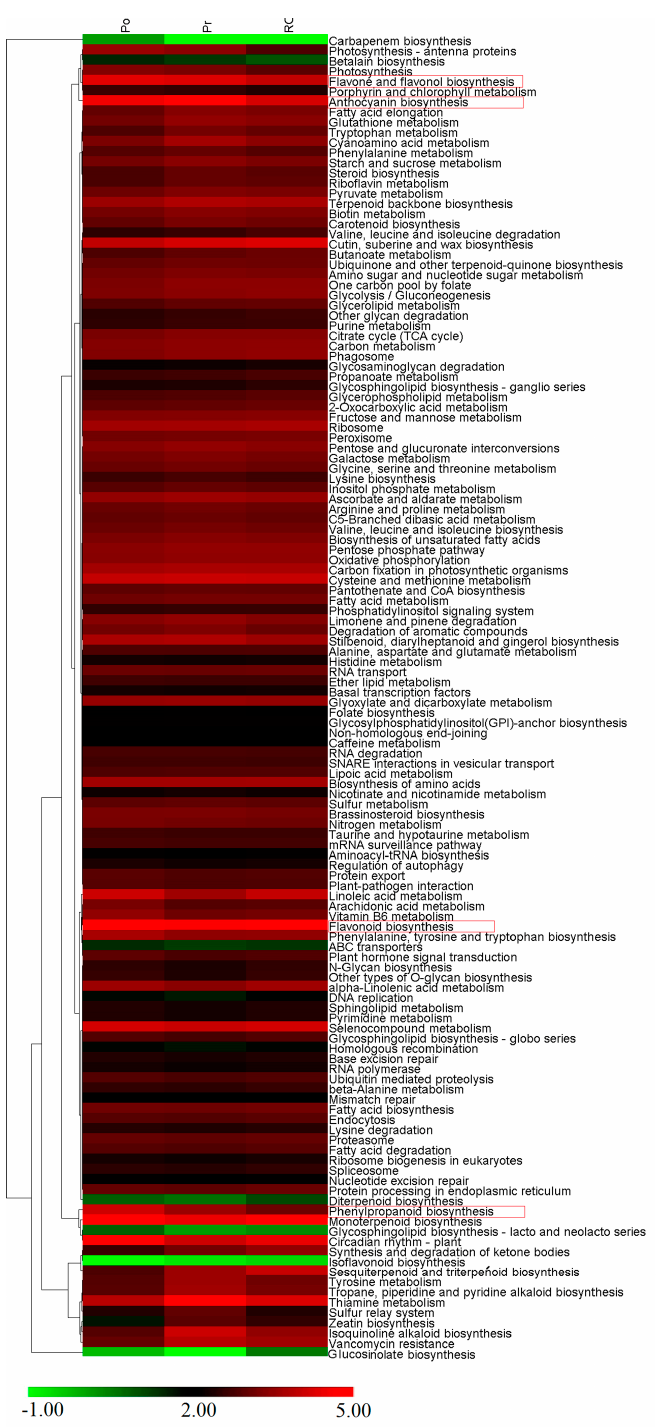
Figure 5. Expression profiles of 130 KEGG pathways. The heatmap is generated according to the average expression levels of the genes in each pathway based on log ratio FPKM data. The color scale represents log2 transformed FPKM values. Green indicates low expression, and red indicates high expression.